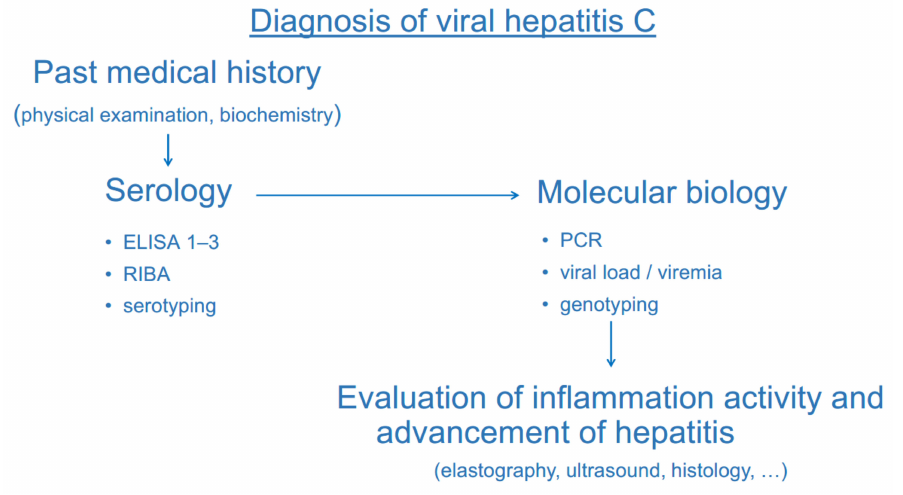
Figure 4. Diagnostic procedures of viral hepatitis